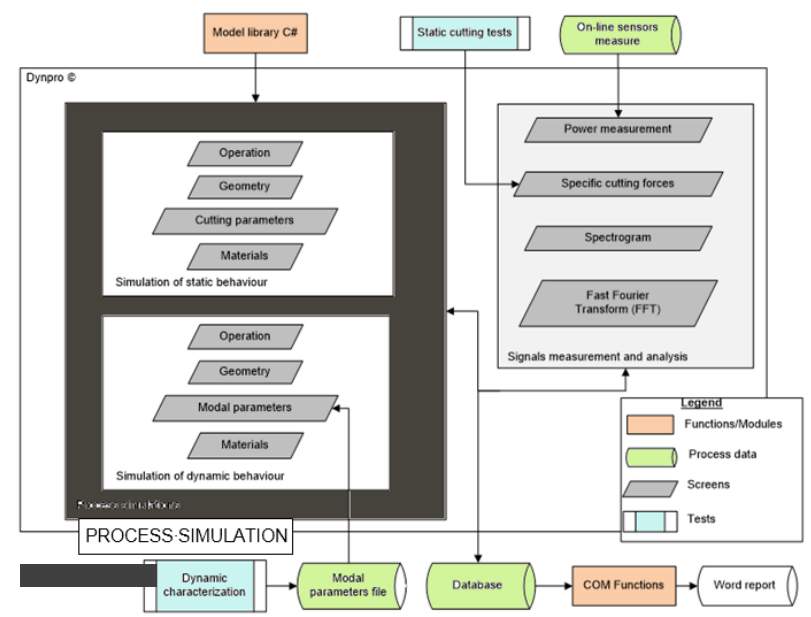
Figure 4. Approach workflow: experimental test and flows.